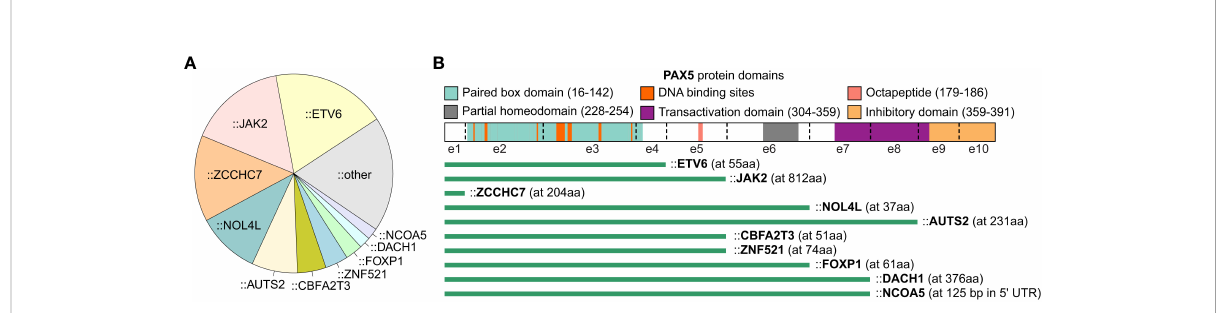
FIGURE 2 PAX5 rearrangements in B-ALL. The summary of PAX5 rearrangements is based on the result from the 1,988 B-ALL cohort (16). (A) Distribution of PAX5 fusion partners. The fusion partners observed in at least 2 B-ALL cases are annotated in the pie chart, and the singletons are merged into the “ other ” group. (B) Scheme of PAX5 rearrangements with recurrent partner genes. The most common isoform of each fusion is shown. The green bars indicate the remaining part of the PAX5 protein. The starting amino acid (aa) of the fusion partners are annotated in parentheses. All the rearrangements reserve the paired box DNA binding domain of PAX5, except the fusions with ZCCHC7 , a proximal gene commonly fused with PAX5 by focal